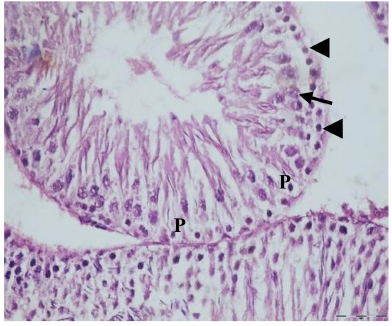
Figure 4. Section of testis of rats treated with paracetamol for 15 days showing disorganized arrangement of spermatogenic cysts (arrows), separated and ruptured basement membrane of the germinal epithelial cells (head arrows), degenerated germ cells with pyknotic nuclei (P) (H&E ×